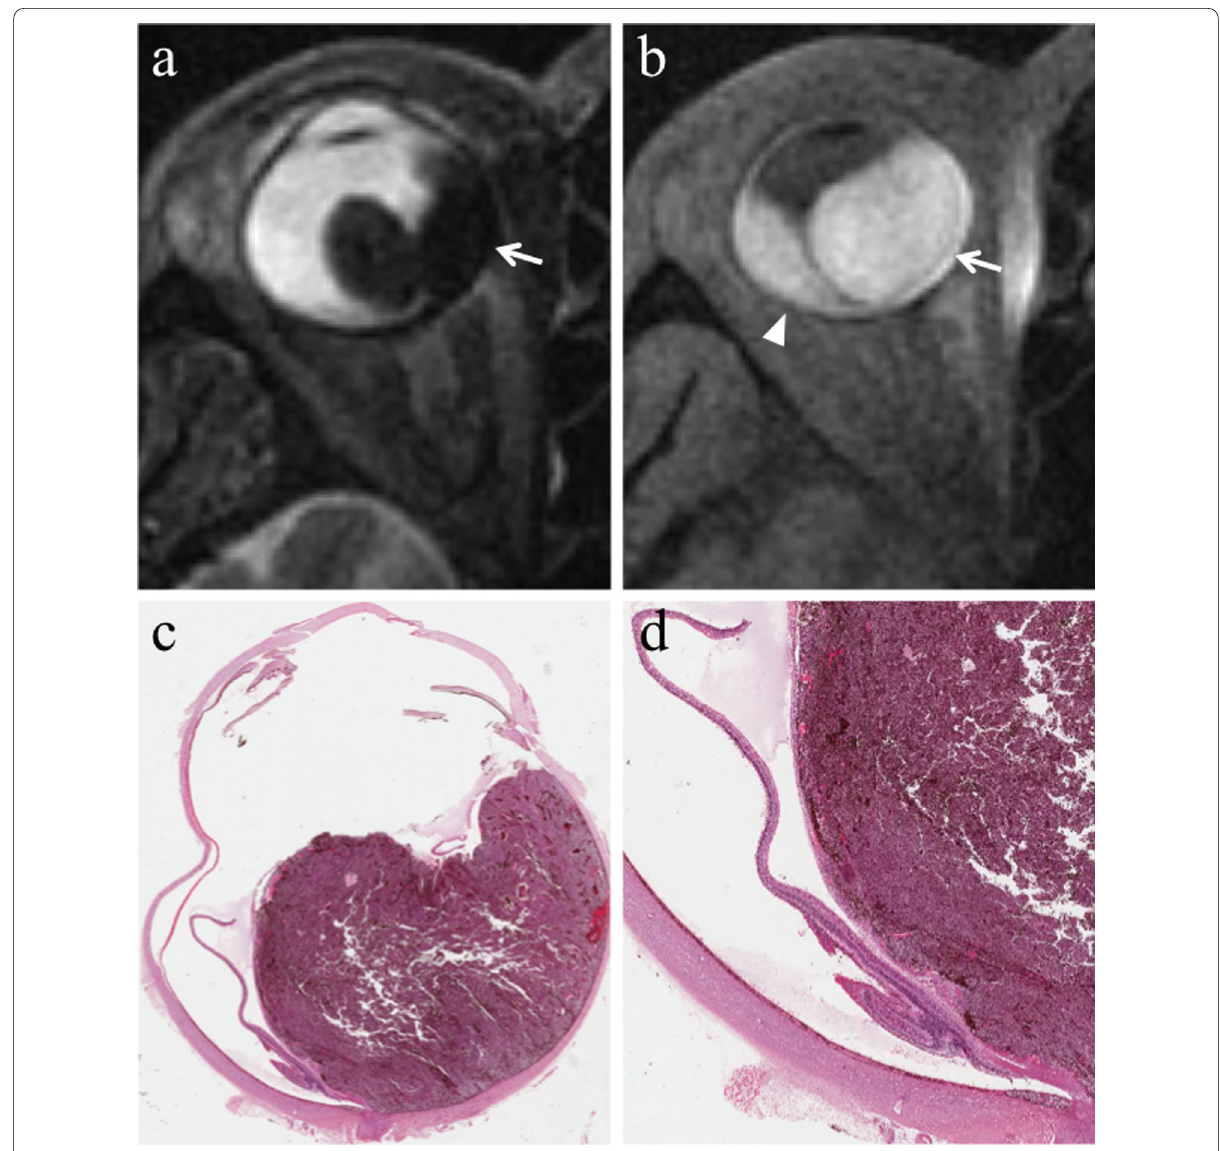
Fig. 7 A 77-year-old man with a pigmented choroidal melanoma and hemorrhagic retinal detachment of the right eye. Axial ( a ) T2-weighted turbo spin-echo STIR and ( b )( fat-suppressed T1-weighted images demonstrate an intraocular mushroom-shaped lesion along the postero-medial aspect of globe (white arrows). The mass exhibits the typical low signal intensity (lower signal intensity than vitreous body) on T2-weighted image and high signal intensity (higher signal intensity than vitreous body) on T1-weighted image. Along the postero-lateral aspect of globe, the hemorrhagic retinal detachment is better depicted on fat-suppressed T1-weighted image in which it displays high signal intensity due to subacute blood products (white arrowhead in b ). ( c ) Histological examination: low magnification confirming the radiological finding of an intensely pigmented mass protruding from the postero-medial ocular wall (H&E, original magnification 25). ( d ) The postero-lateral retinal detachment is also well × documented at histological level (H&E, original magnification ×